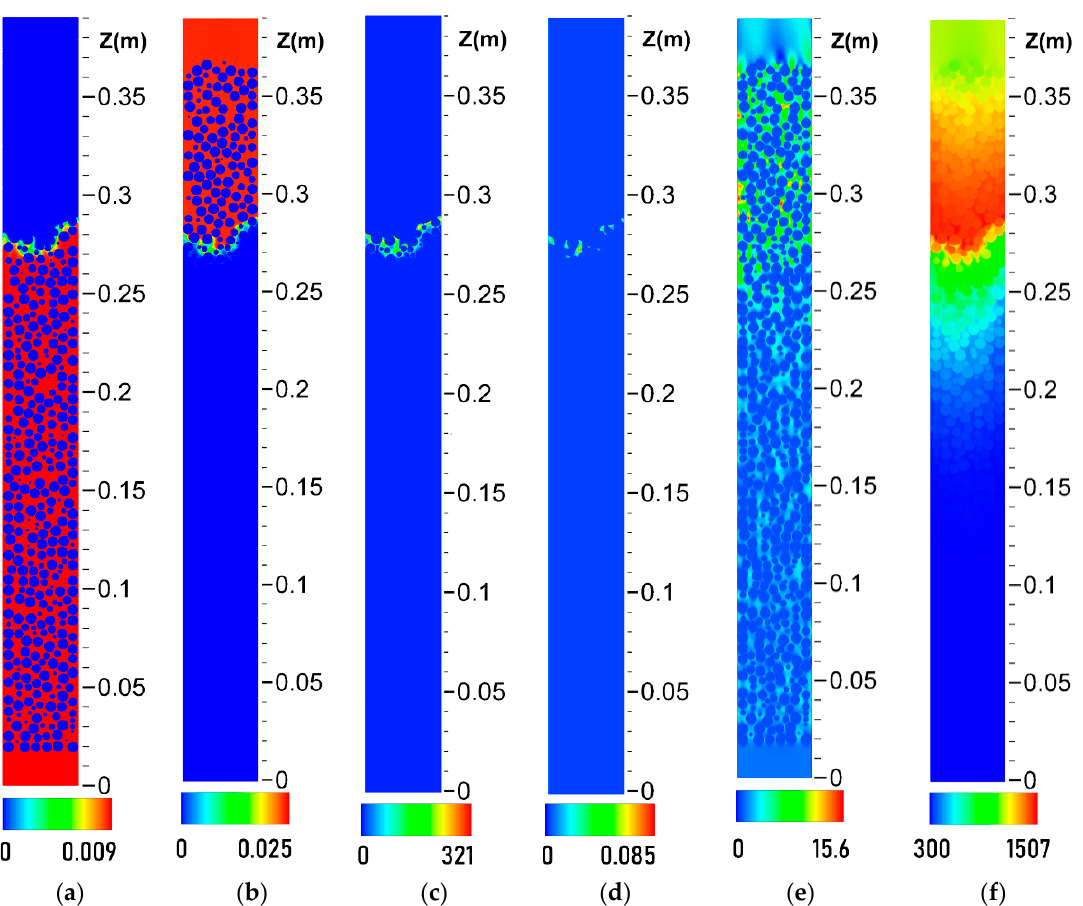
ω Figure 5. The predicted Y CH4 , Y CO2 , ω CH4 , reaction heat, axial velocity and temperature ( y = 0) for ϕ = 0.15, u g = 0.63 m/s Figure 5. The predicted Y CH4 , Y CO2 , ,reaction heat, axial velocity and temperature ( y = 0) for =0.15 ϕ , u g = 0.63 m/s at t CH4 at t = 734 s. ( a ) Y CH4. ( b ) Y CO2. ( c ) ω CH4 /mol/m 3 s. ( d ) Reaction heat/W. ( e ) Axial velocity/m/s. ( f ) T = 734 s. ( a ) Y CH4. ( b ) Y CO2. ( c )